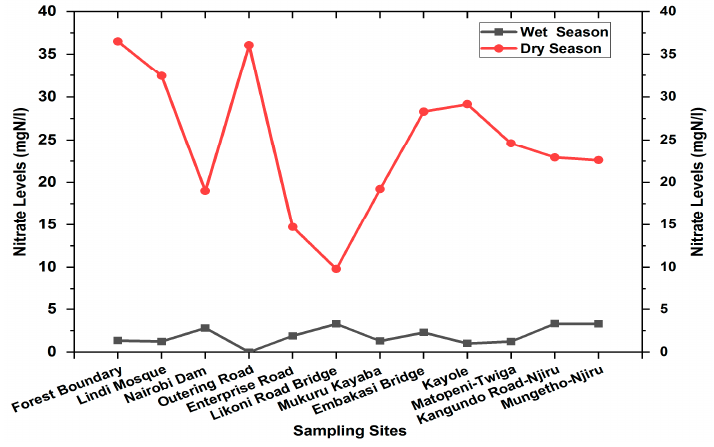
Figure 7. Nitrates levels of Ngong River measured between April and August 2021.